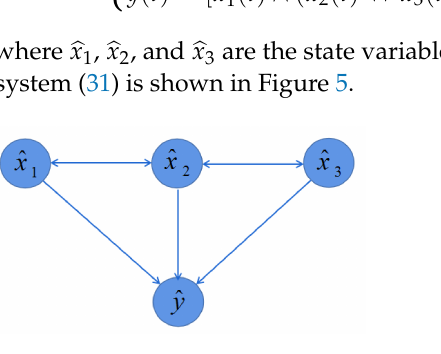
Figure 5. Network diagram of system